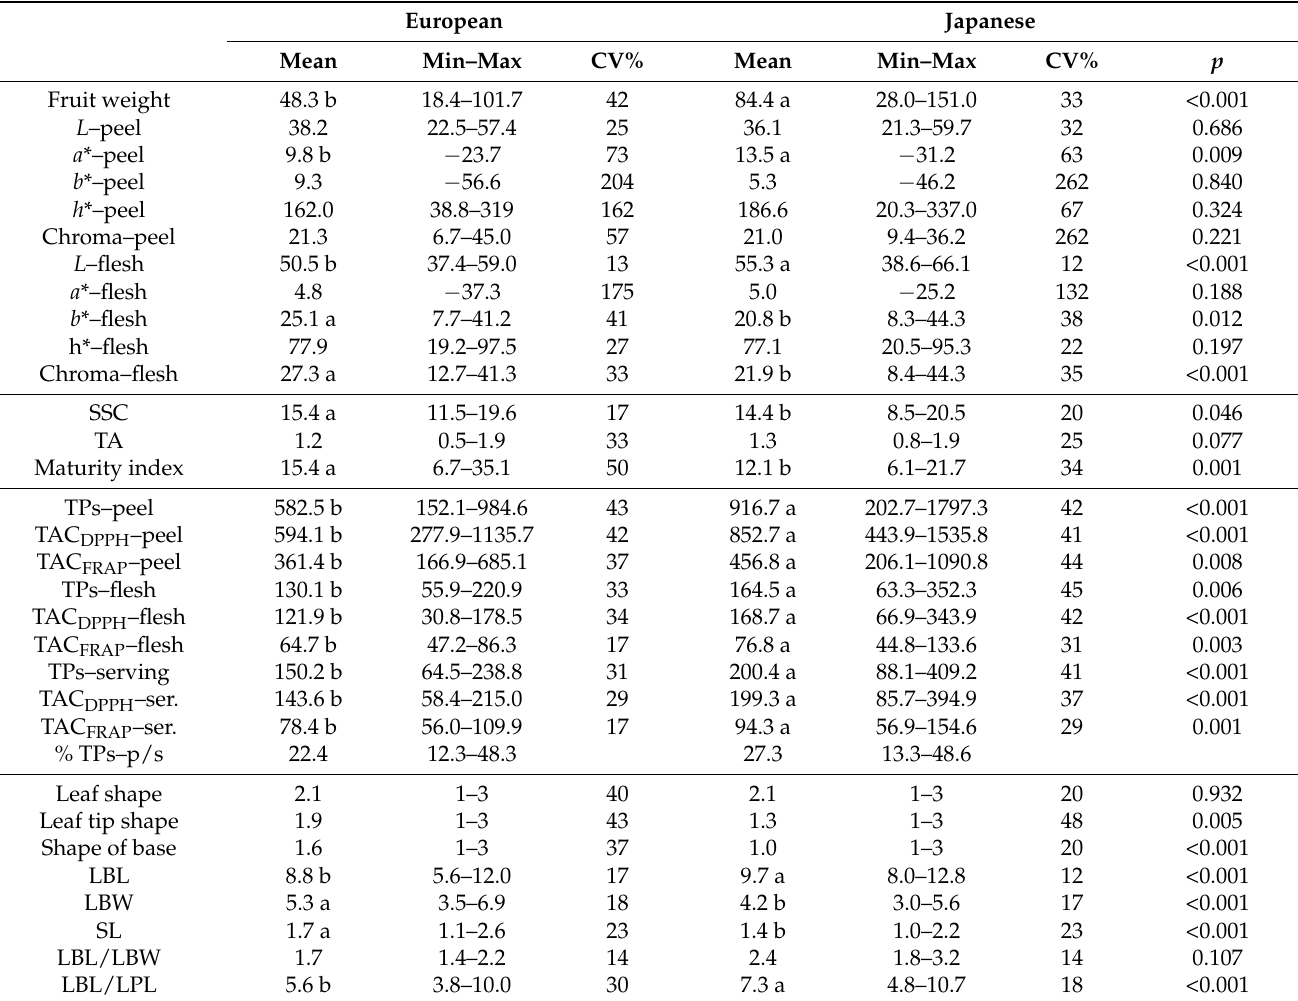
Table 2. Mean (minimum–maximum), percentage coefficient variation (CV%), and p values of fruit quality and leaf traits when compared among 19 European and 24 Japanese plum cultivars grown in a cultivar evaluation orchard in Naoussa, Greece. Parameters measured were fruit fresh weight (g), peel and flesh color CIELAB parameters, soluble solid content (SSC, ◦ Brix), titratable acidity